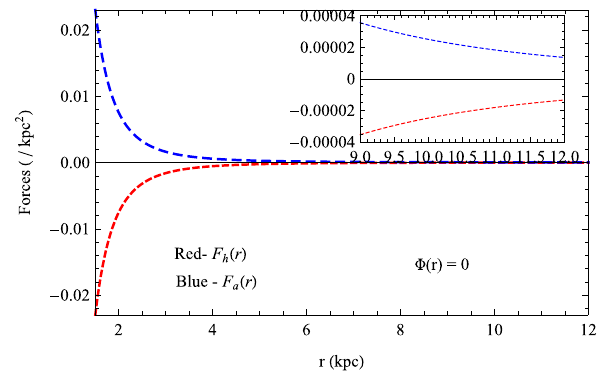
Fig. 16 Two forces are plotted with respect to the radial coordinate r corresponding to the parameters η = 0 . 003, ρ 0 = 0 . 004 kpc − 2 , α = 0 . 5 , β = 0 . 8 , r th = 1 kpc and r 0 = 2 kpc